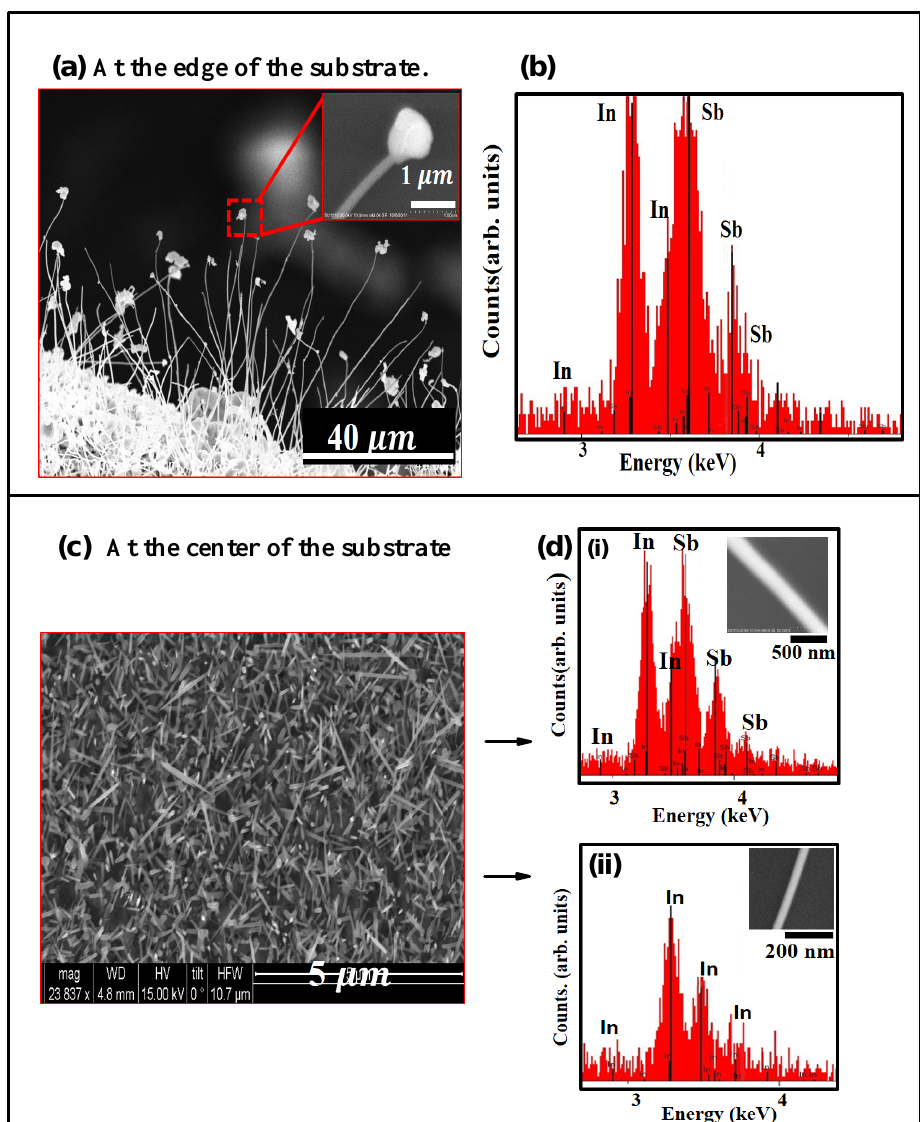
Figure 2. SEM image and EDX spectrum of the InSb NWs that are grown along the edge and at the center of the substrate: ( a ) SEM image showing a high density of NWs, growing from a bed of clusters or islands along the edge of the Si substrate. Inset shows a single NW with a highly deformed tip; ( b ) EDX spectrum of as grown NWs showing the NWs have a stoichiometric composition with In : Sb of 1:1; ( c ) SEM image showing a high density of NWs at the center of the Si substrate. There are no clusters or islands visible at the base of the NWs, as was evident in ( a ). The NWs grown in this region have different diameters and some were also found to have tapered ends; ( d ) NWs with diameter larger than 200 nm were InSb NWs, confirmed by the EDX spectrum shown in ( d-i ). NWs that have diameter less than 100 nm are In NWs, verified by the EDX spectrum shown in ( d-ii